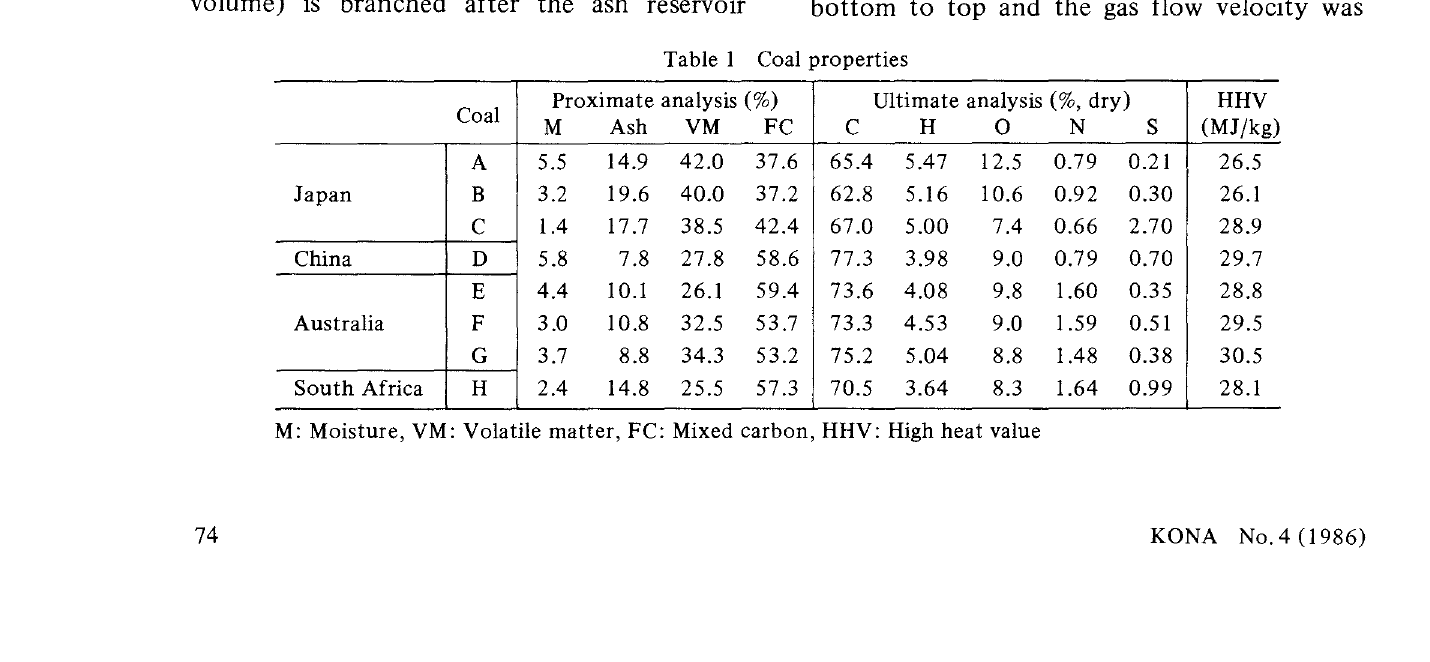
Fig. 1 Experimental apparatus and introduced into the cylindrical electro static precipitator. The temperatures of cy clone and bag-filter are maintained to be 450°C and 100° C, respectively. The electrostatic precipitator consists of a discharge electrode wire of 0.4 mm in diameter set at the center line of the cylinder and a cylindrical collect ing electrode which is 70 mm in inner diameter and 630 mm in length piled of nine cylindrical stages. At the exit of the electrostatic precipi tator, a back-up filter is set to collect the sub micron fine particles passed through the stages of electrostatic precipitator. The whole part of the electrostatic precipitator is heated up to be 150°C. Combustion products flows from the bottom to top and the gas flow velocity